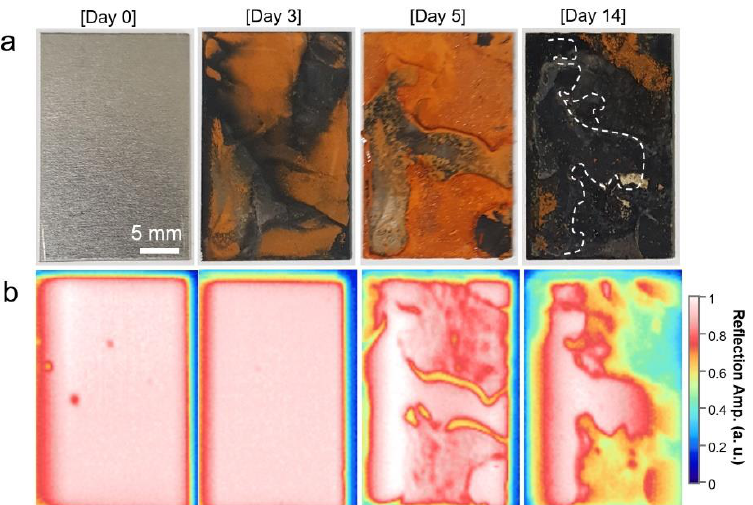
Figure 4. ( a ) Photographs of the steel plate taken on different days after the plate was submerged in the NaCl solution. ( b ) THz reflection amplitude images from the rusted metal plate taken on different days. Dashed line in ( a ) is a guide to eye for a direct comparison between the photographic image and THz image.